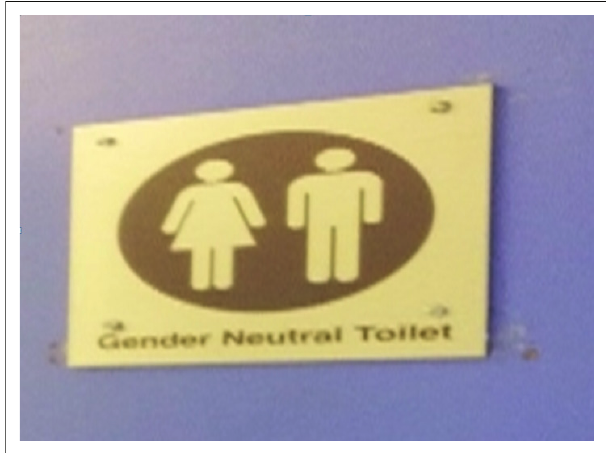
FIGURE 2: Toilet sections for gender-neutral